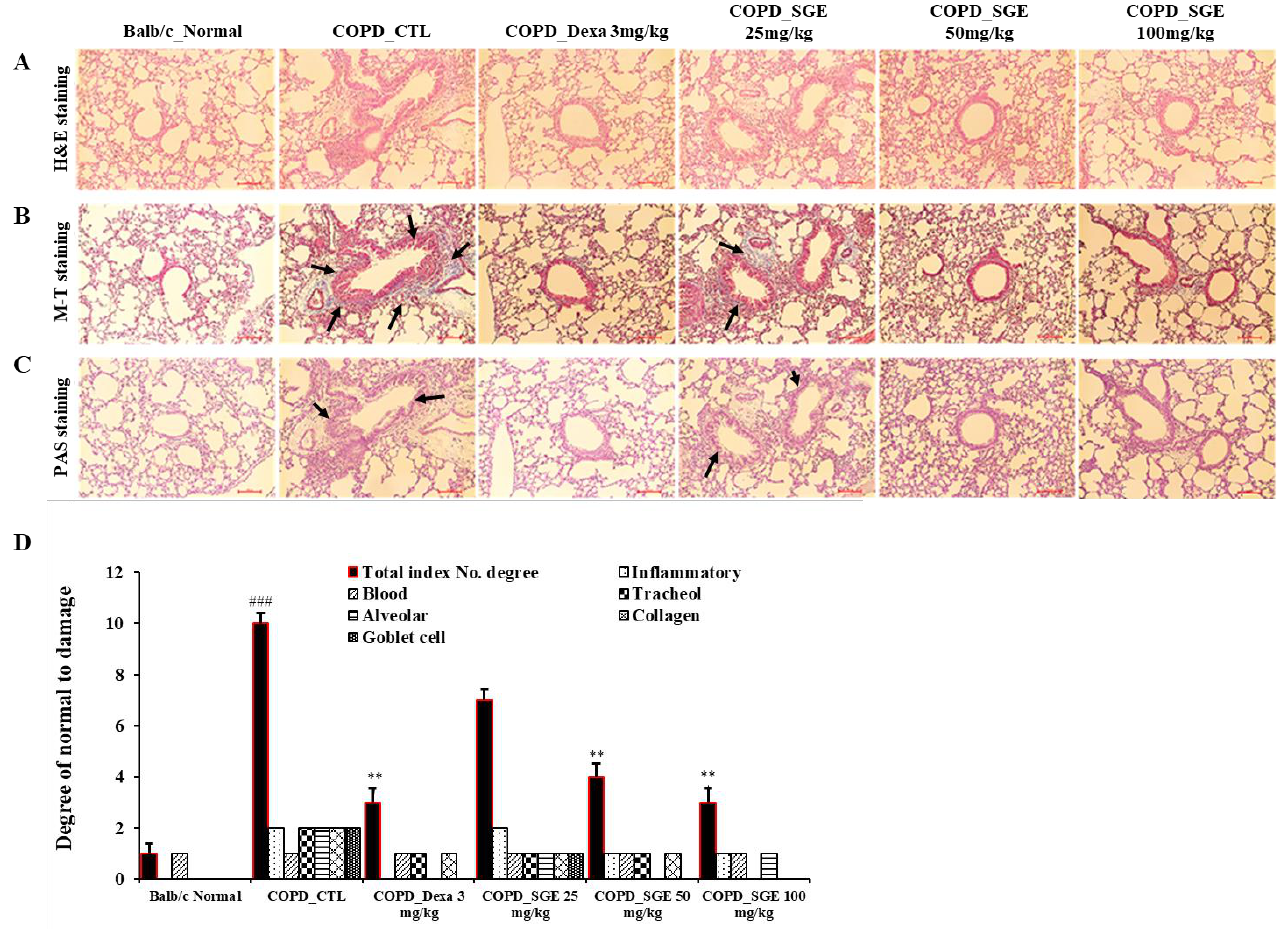
Figure 6. Effects of SGE on histopathological markers for lung tissue of COPD-induced mice. Lung tissue was sectioned in paraffin and stained for histological analysis. ( A ) H&E staining showing immune cell infiltration and the morphology of small airways. ( B ) M-T staining showing collagen fibers increased by pulmonary fibrosis. Black arrows indicate blue-dyed collagen fibers. ( C ) PAS staining showing hyperplasia of goblet cells in small airways. Black arrows indicate goblet cells. Scale bar = 100 µm. ( D ) Total index number were quantitated. The data are presented as means ± SEM (n = 6 mice) for individual mice. ### p < 0.001 compared to normal, and ** p < 0.01 compared to control. Dexa, dexamethasone.